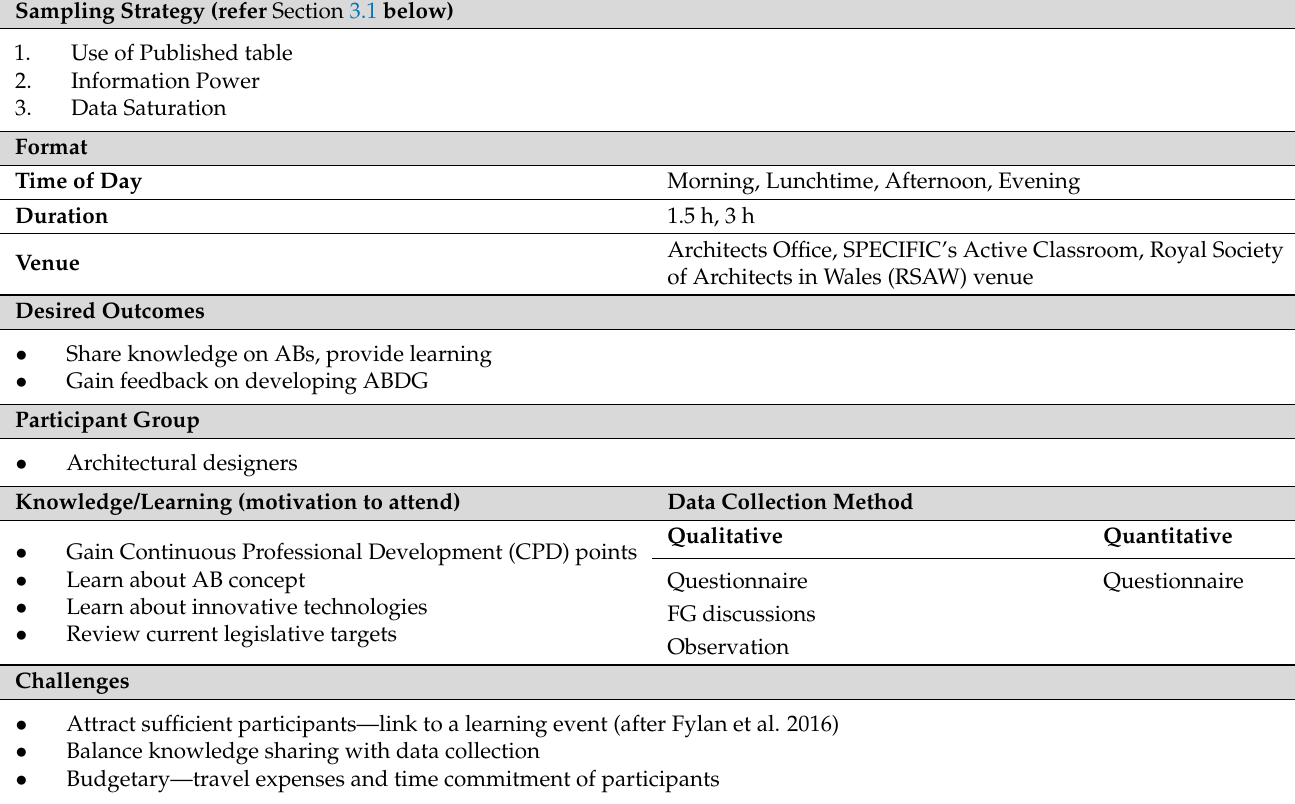
Table 2. Summary of Key Factors influencing FG design, as determined by the first author during this study